Question: According to the figure, is the described quantity increasing or decreasing?
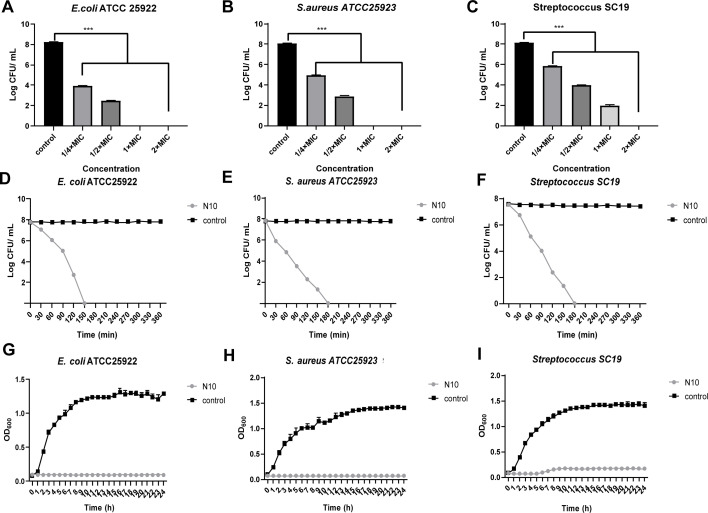
Answer: increasing